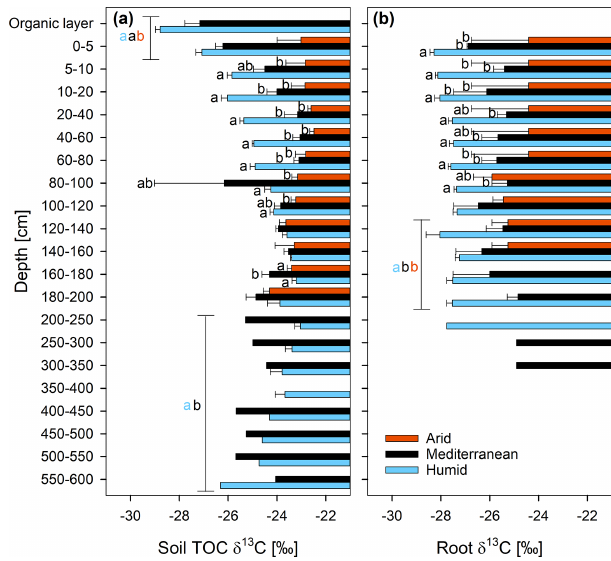
Figure 3. 13 C ratio ( δ 13 C; mean ± standard error) of (a) soil total organic carbon (TOC) and (b) roots at three sites (arid, mediter- ranean, humid) located along a precipitation gradient in the Coastal Cordillera of Chile (0–200cm: n = 3, except for humid site with n = 4; 200–600cm: n = 1, except for humid site 200–400cm with n = 2). Different letters in (a) and (b) indicate significant differ- ences ( p ≤ 0 . 05) among the sites tested by Tukey’s post hoc test after two-way ANOVA. Lines in (a) and (b) indicate which soil depth increments were combined (separately per site) for statistical analysis.